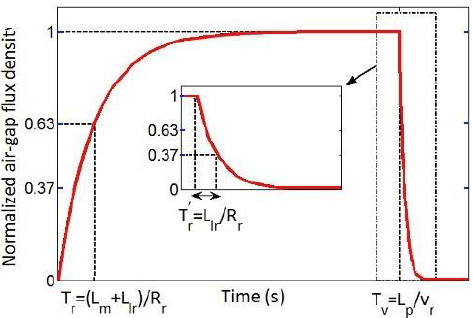
Figure 2. Normalized air-gap flux density versus